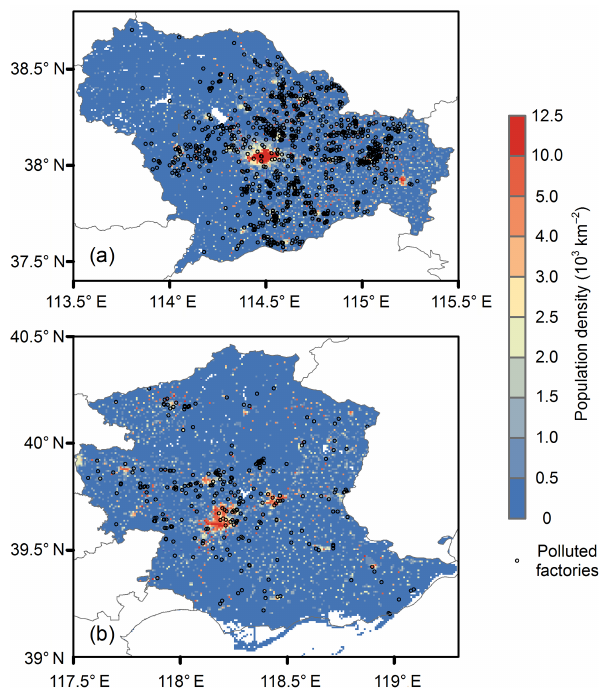
Figure 4. The spatial distributions of polluted industries and popu- lation in (a) Shijiazhuang and (b)